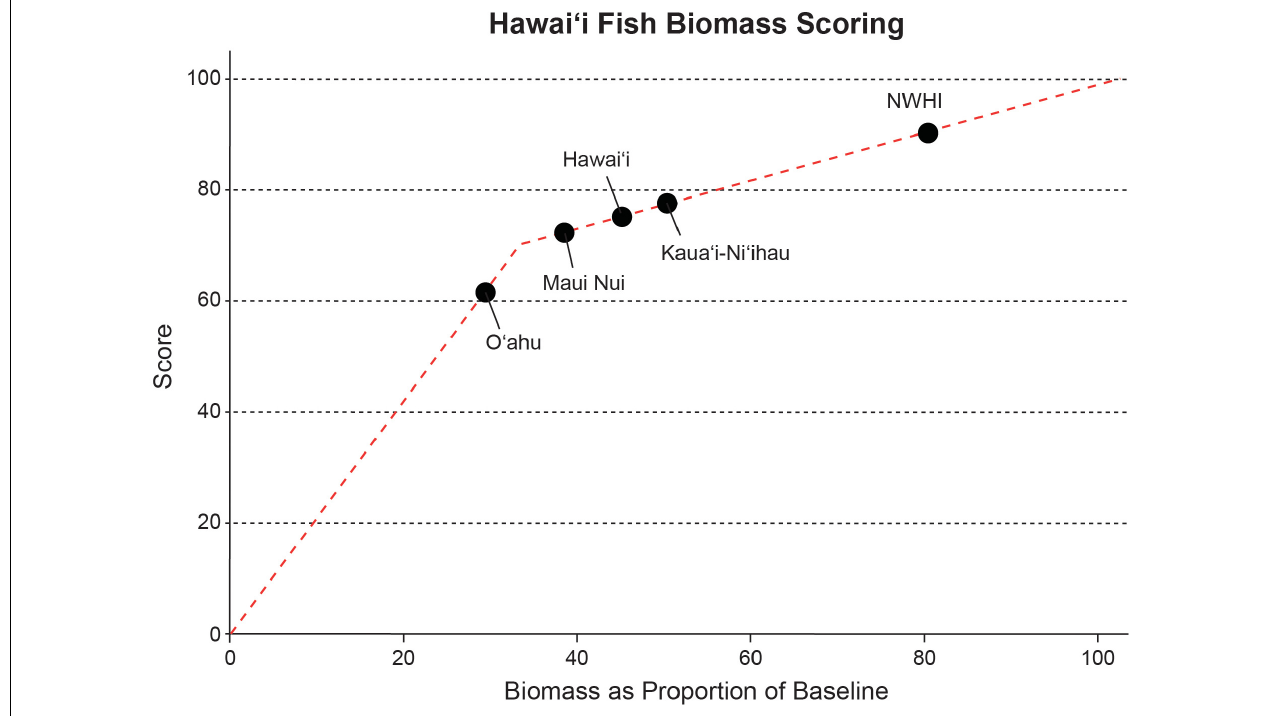
FIGURE 2 | Scoring plot for the Main Hawaiian Islands (O‘ahu, Maui Nui, Hawai‘i, and Kaua‘i-Ni‘ihau) and the Northwestern Hawaiian Islands (NWHI) fish biomass using Williams et al. (2015) as the baseline.